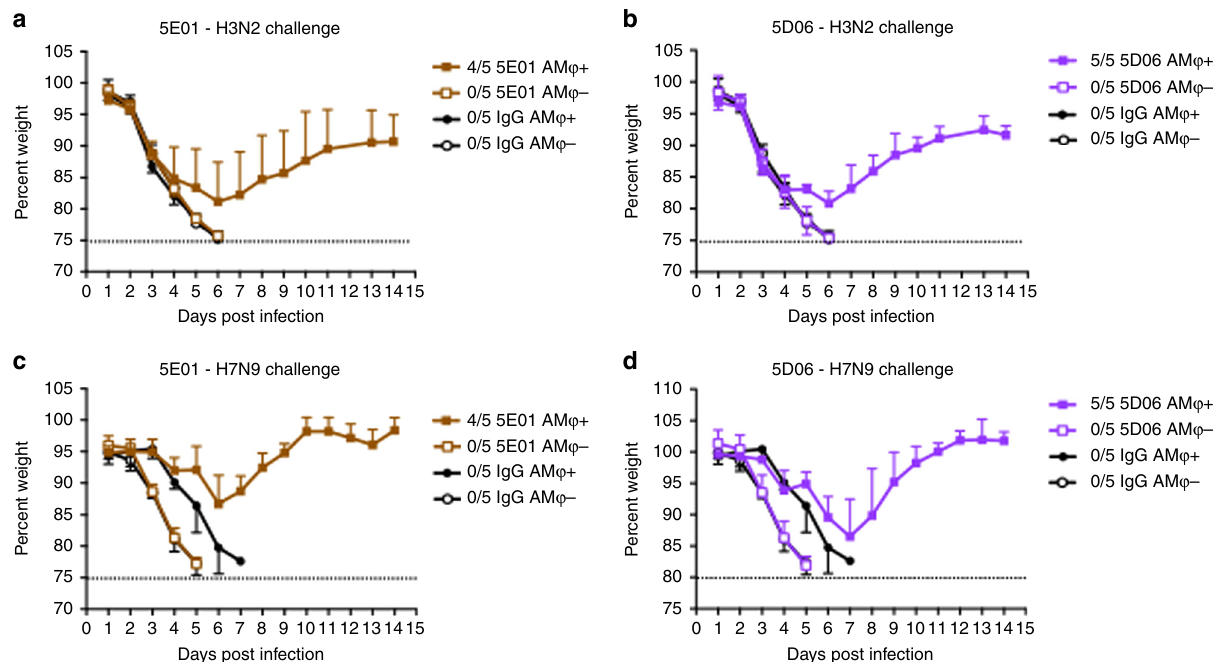
Fig. 5 Heterosubtypic protection provided by human nonNAbs requires AM φ . BALB/c mice were treated IN with clodronate liposome to deplete AM φ . PBS liposome was used in non-depleted groups. Mice received 6 mg per kg ( a ) 5E01or ( b ) 5D06 IP, and then were challenged IN with 5 mLD 50 of X31 (H3N2). Another set of mice were administered IP with 3 mg per kg ( c ) 5E01 or 2 mg per kg ( d ) 5D06, and then challenged IN with 10 mLD 50 of A/Shanghai/1/13 (H7N9). The ratios in the fi gure legends indicate the number of animals that survived challenge over total number of animals per group. Values represent mean ±